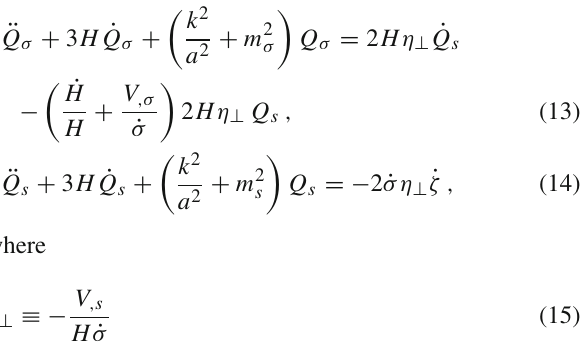
− i ((cid:9)(μ)/π)( 2 /ξ) μ for small | ξ | , where (cid:9) is the